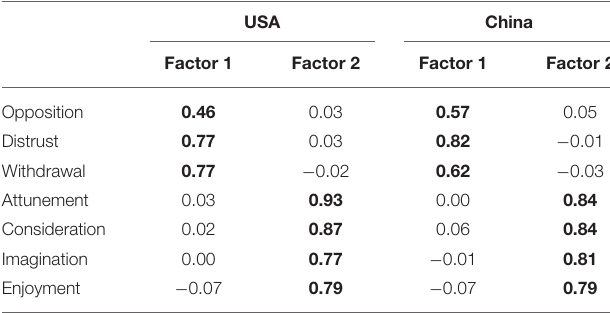
TABLE 1 | Study 1 (USA) and Study 2 (China) EFA factor loadings for the child sociomoral orientation measure